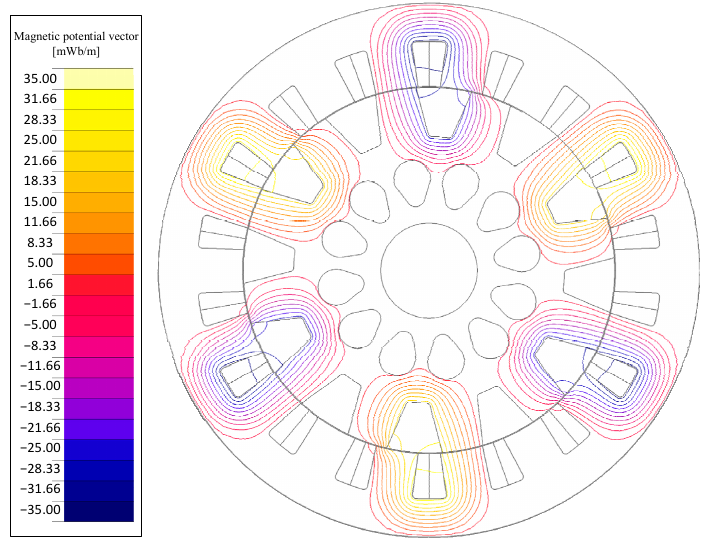
Figure 15. Magnetic potential vector in the dynamic model of 18/12 SRM.